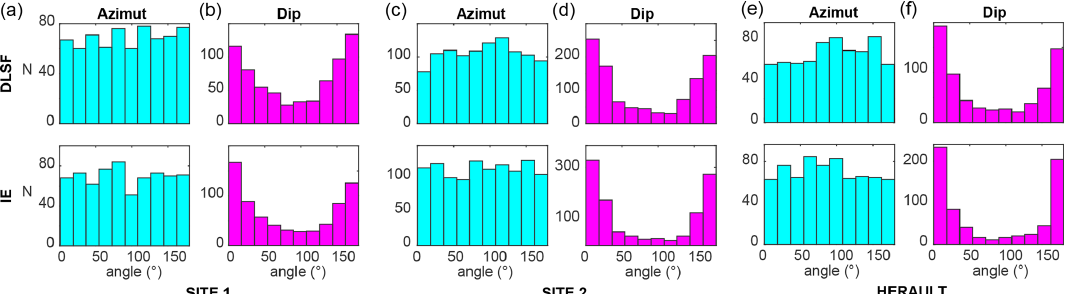
Figure 9. Azimuth and dip angles of the grains fitted to the two approaches (DLSF and IE) at (a–b) Site 1, (c–d) Site 2 and (e–f) the Hérault River. N is the number of grains of a given angle in